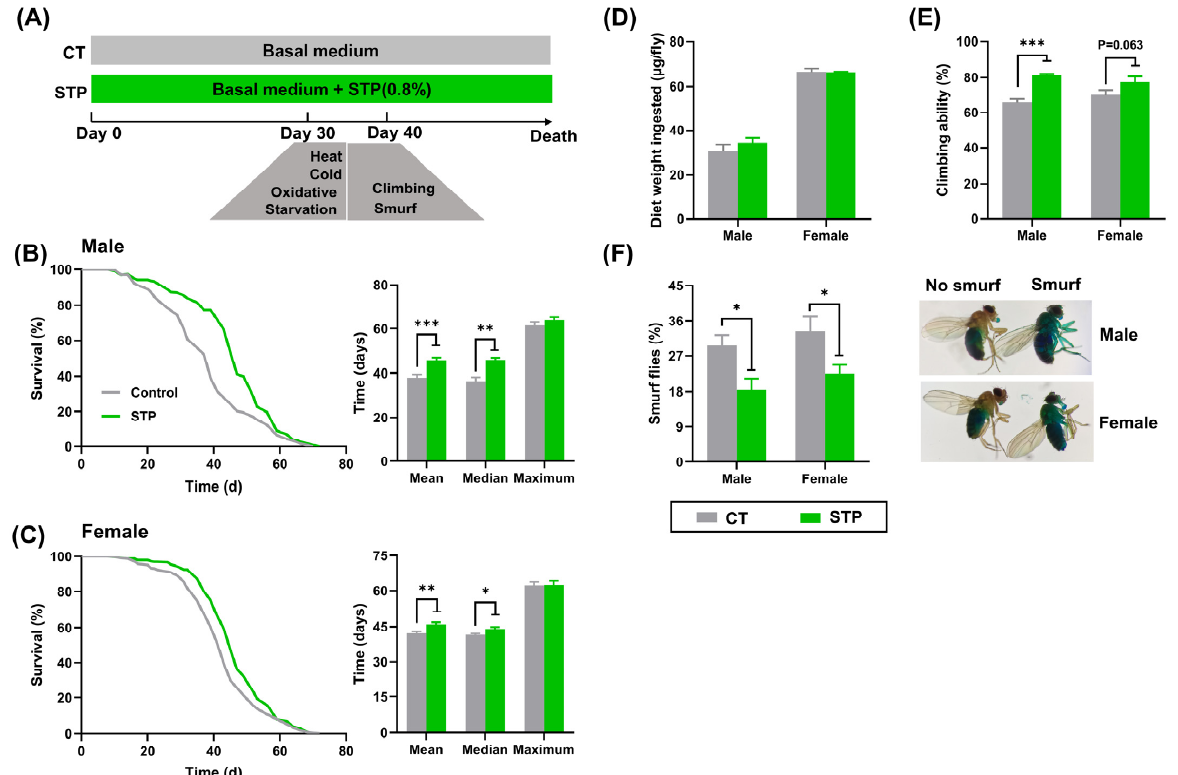
Figure 1. STP extended lifespan and improved healthspan in flies. ( A ) The scheme for animal experiment; Lifespan curves of male flies ( B ) and female flies ( C ); ( D ) Food intake; ( E ) Climbing ability; ( F ) Smurf flies. Data are shown as mean ± SEM. Statistical test: two-tailed unpaired t -test (* p < 0.05, ** p < 0.01, and *** p < 0.001 vs. CT group).